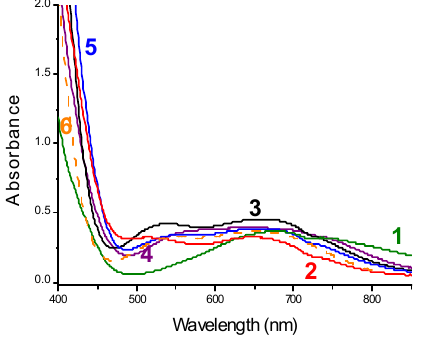
Figure 27. Optical pyrometric measurements under air for the redox polymerization of an UDMA/1,4-HPMA/1,4-BDMA blend using the two-component system Cu-x (x = 34-41) /2-dppba (1%/1.5%, w / w ) ( A ) . (1) Reference system 4- N,N -TMA/BPO (0.8%/1% w / w ). (2) Cu-40 . (3) Cu-35 . (4) Cu-36 . (5) Cu-39 . ( B ) . (6) Cu(acac) 2 . (7) Cu-38 . (8) Cu-41 . (9) Cu-37 . (10) Cu-34 . Reproduced with